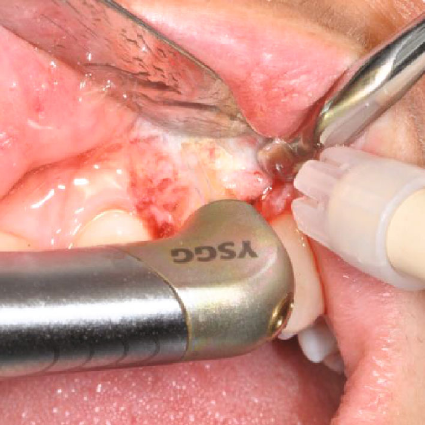
Figure 3: Phases of